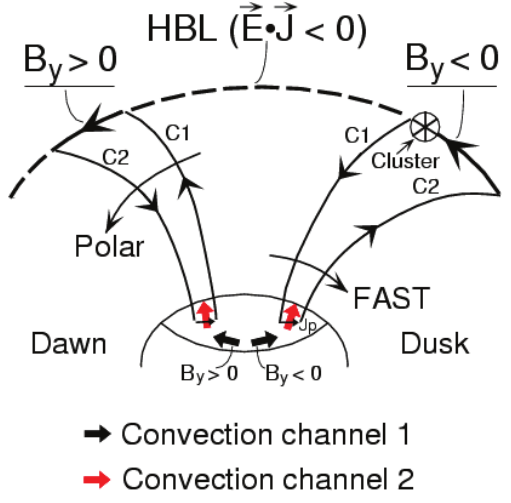
Fig. 12. Schematic of the IMF B y -dependent FAC system located poleward of the R1 current. The red arrow marks plasma convection channels associated with the closure of the C1/C2 current system. Locations of Polar during the first example and Cluster and FAST during the second example are